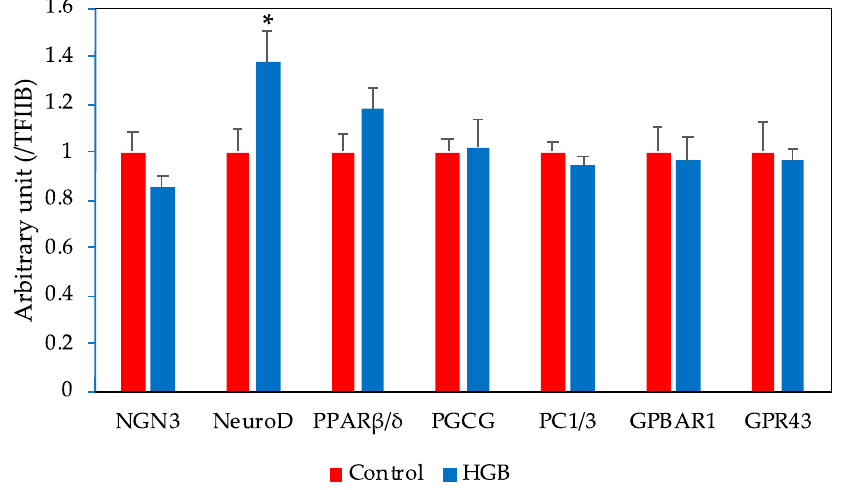
Figure 3. Expression of mRNAs related to L cell function in the ileum bars represent means and standard error of the mean (SE), n = 8. Means marked with an asterisk differ significantly